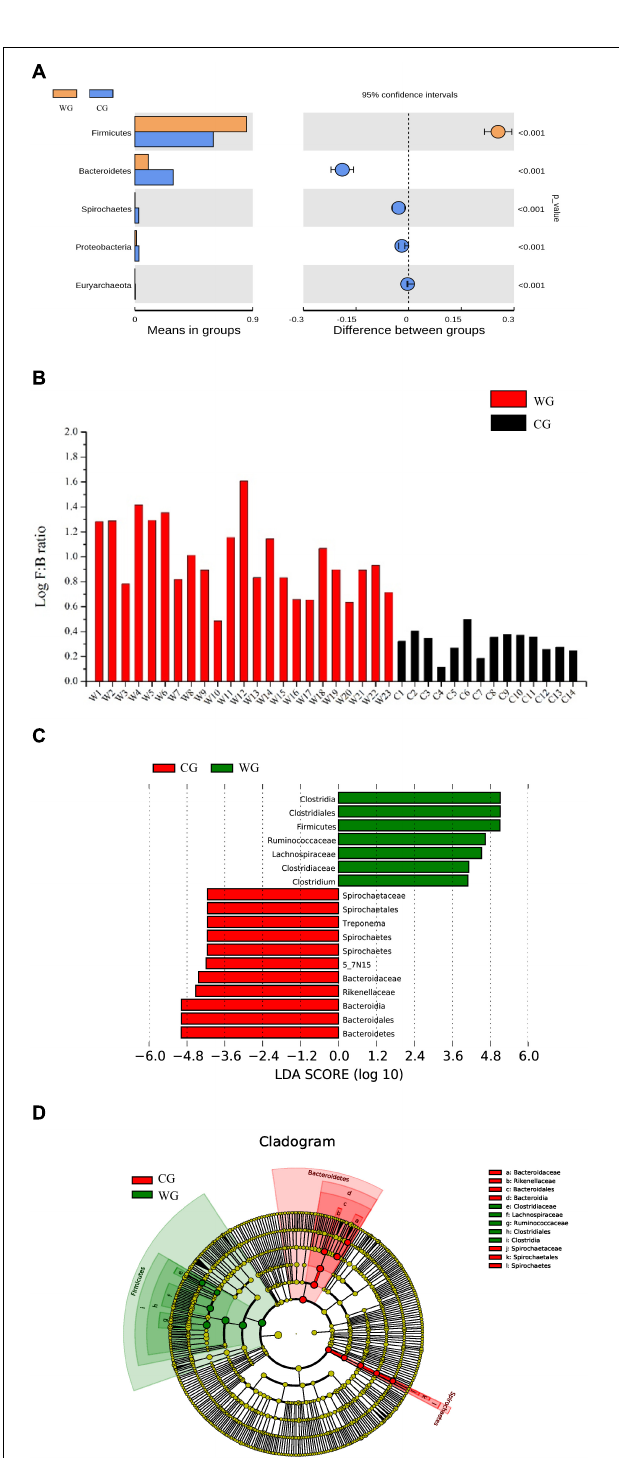
FIGURE 2 | Bacterial taxa showing significant differences between the two groups as detected by Wilcoxon test and LEfSe analysis. (A) Species with a significant difference ( p < 0.05) at the phylum level based on the Wilcoxon test between the two groups. (B) Log F/B ratios in CG and WG individuals are clearly different (red: WG, black: CG). (C,D) Distribution histogram of LDA and system evolutionary distribution based on biomarkers with statistically significant differences in abundance between the two